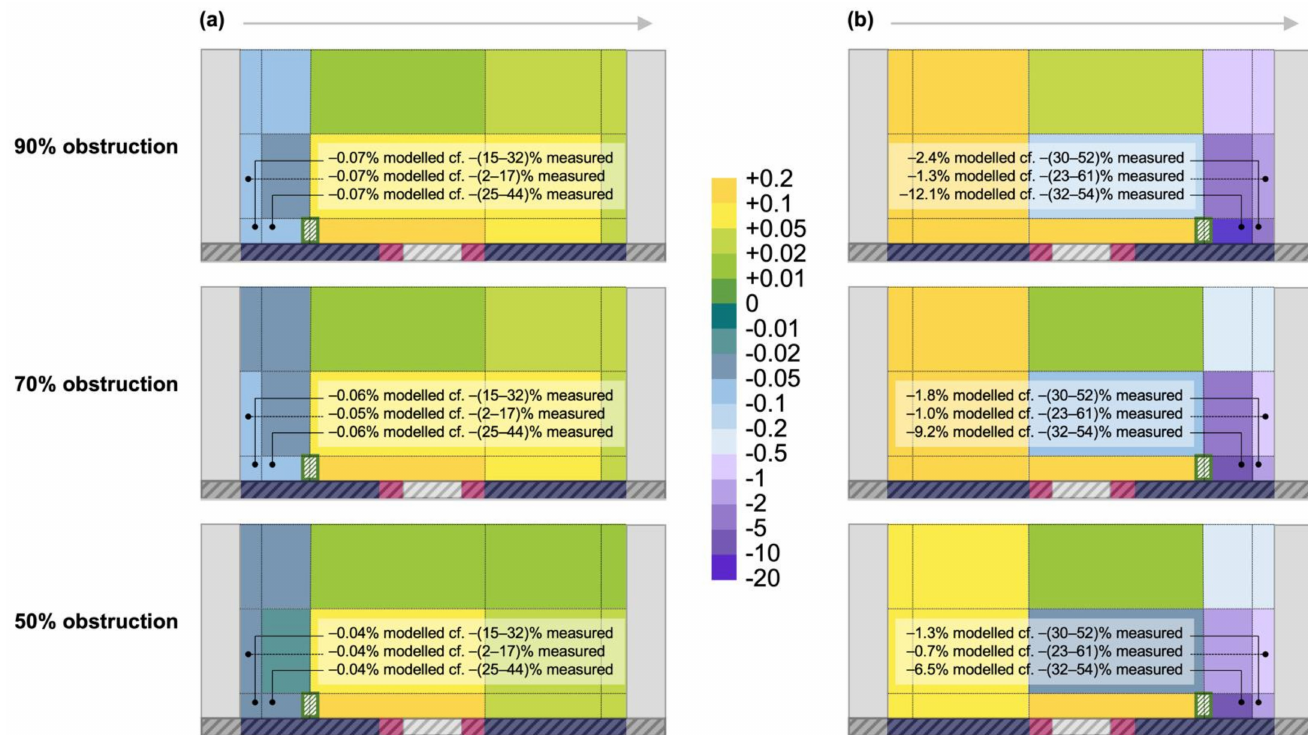
Figure 12. Modelled changes in SF 6 mass concentration (%), on introducing a roadside barrier in a street canyon under perpendicular wind conditions aloft, when the barrier is located ( a ) upwind and ( b ) downwind relative to the wind aloft, as we seek to emulate [49]’s wind tunnel